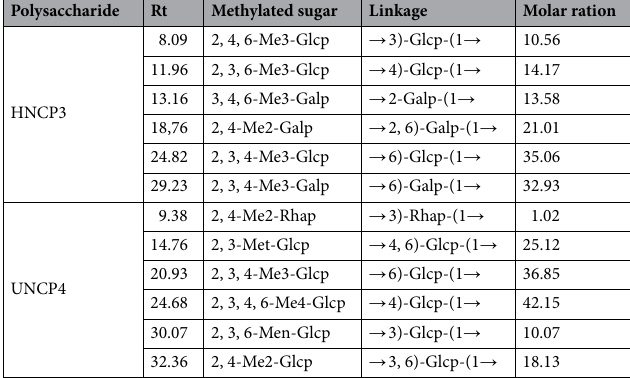
Table 2. Methylation analysis of HNCP3 and UNCP4 by